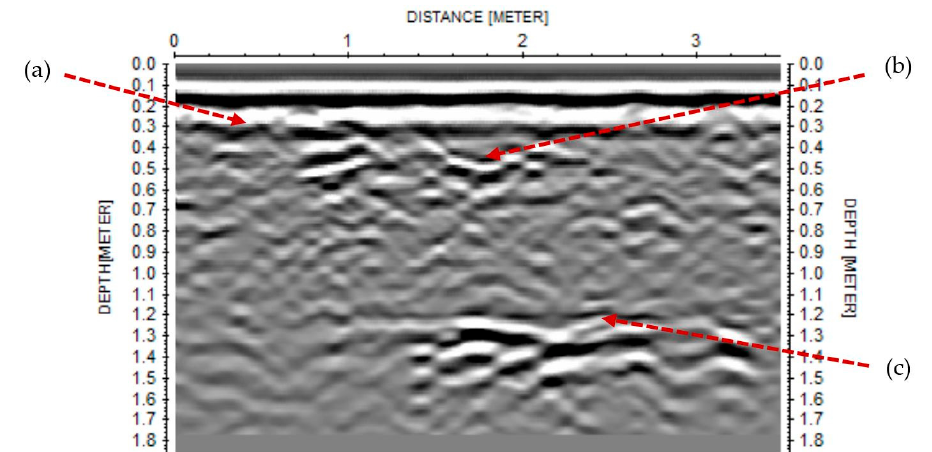
Figure 5. Horizontal georadar reading on the south wall of the nave: ( a ) inner surface of the interior leaf at 35–40 cm depth; ( b ) inner surface of the interior leaf at 55 cm depth (irregular inner surface); ( c ) opposite side (inner surface of the exterior leaf) at 1.20–1.25 m depth.